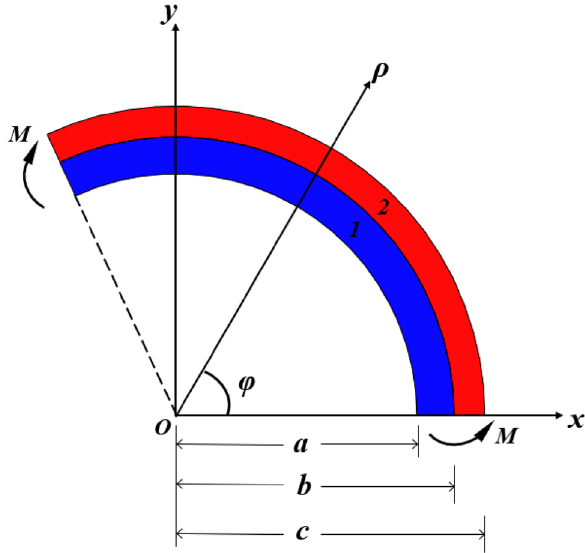
Figure 1. Pure bending of the curved beam under the action of force couple and temperature